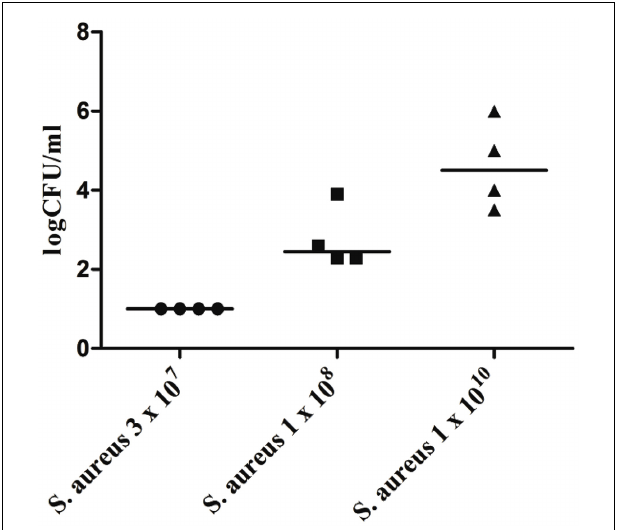
FIGURE 1 | Bacterial concentrations of Staphylococcus aureus AmericanType Culture Collection (ATCC) 29213 in cerebellar homogenates ( n = 4 animals per inoculum) 168 h after intracerebral infection with different inocula of S. aureus under anesthesia. Horizontal bars indicate median values, the detection limit was 10 colony-forming units (CFU)/ml (Marija Djukic, unpublished data). Please note that all mice were able to clear an inoculum of 3 × 10 7 bacteria within 1